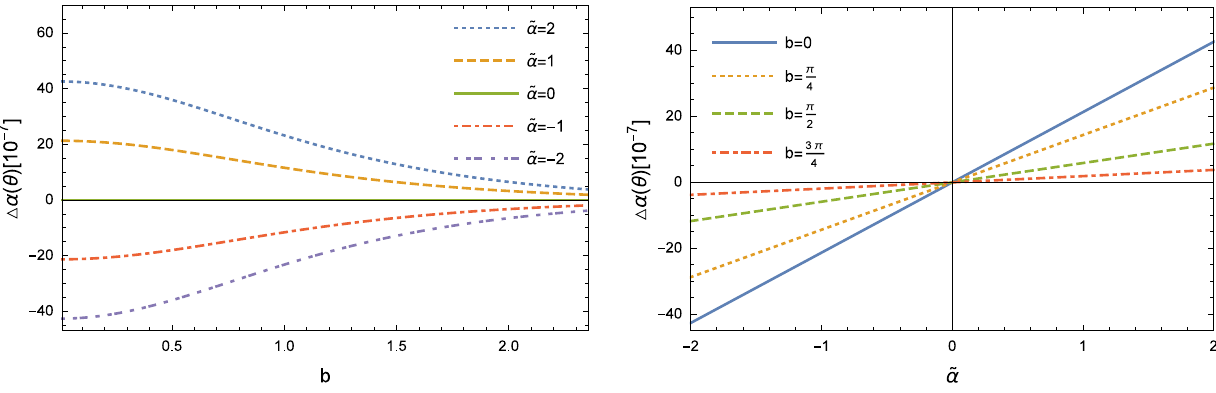
Fig. 4 Variation of the difference of deflection angle (cid:15)α(θ) evaluated at u = u ps + 0 . 003 with the phantom hair b (left) and coupling constant (cid:12) α (right) in the regular phantom black hole (cid:15) u = u − u (cid:15) ¯ a = ¯ a ( − ¯ a ( ps ps ( PPL ) ps ( PPM ) , PPL ) PPM ) and − α(θ) ( (cid:15)α(θ) = α(θ) ( PPL ) PPM ) . Then we plot them with phantom hair b for fixed (cid:12) α and with coupling constant (cid:12) α for fixed b in Figs. 2, 3,